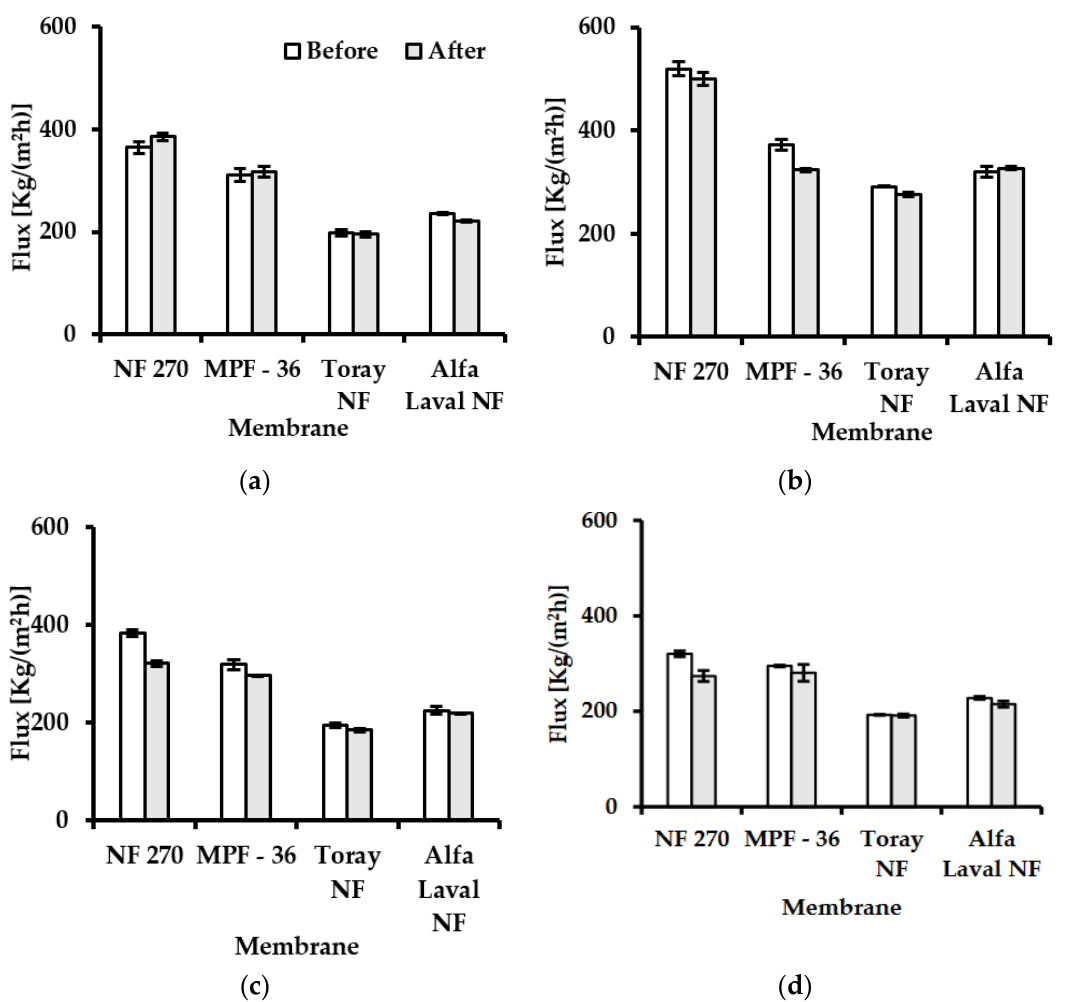
Figure 2. Water flux before and after the experiment with lactic acid for NF270, MPF-36, Toray NF, and Alfa Laval NF membranes. ( a ) at pH 2.8, T: 25 ◦ C and 32 bar. ( b ) at pH 2.8, T: 40 ◦ C and 32 bar. ( c ) at pH 3.9, T: 25 ◦ C and 32 bar. ( d ) at pH 6.0, T: 25 ◦ C and 32 bar.